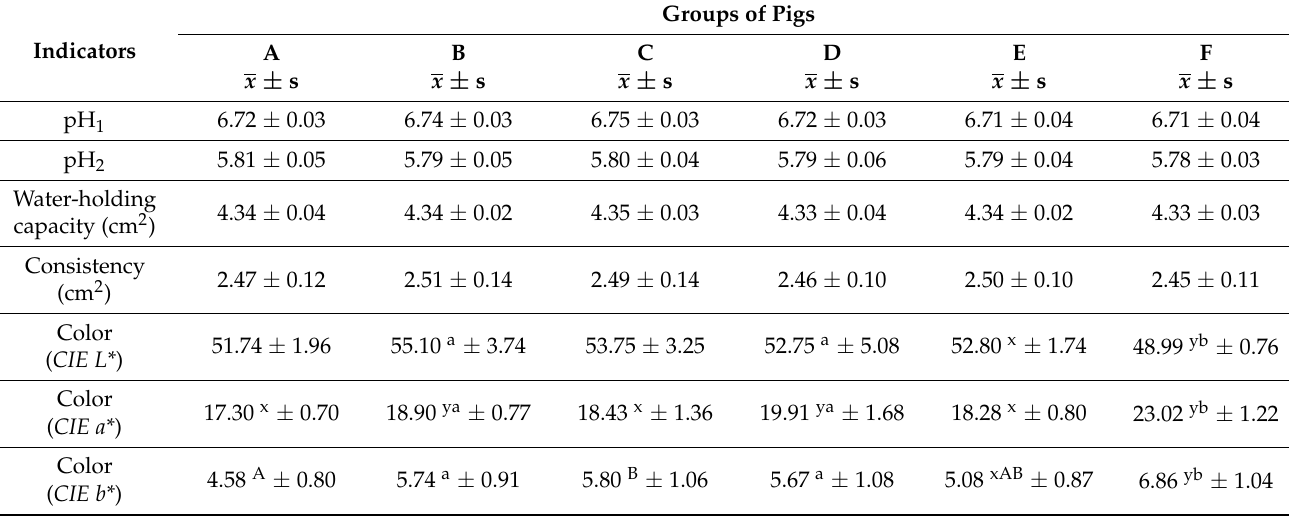
Table 9. Physical properties of